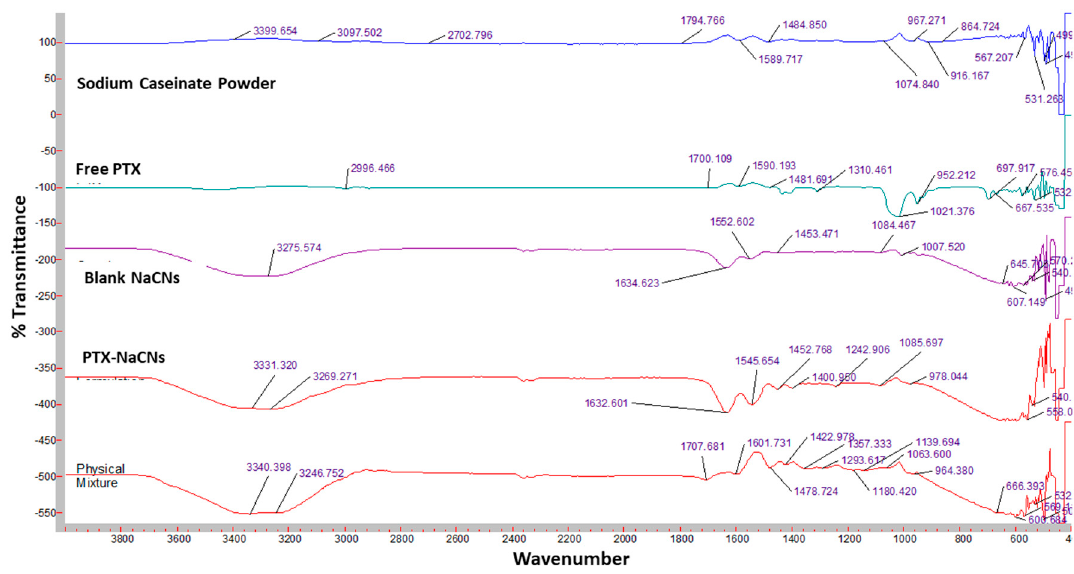
Figure9. Figure 9. FTIR spectra of Sodium Caseinate powder, PTX, Blank NaCNs, PTX-NaCNs and physical mixture.